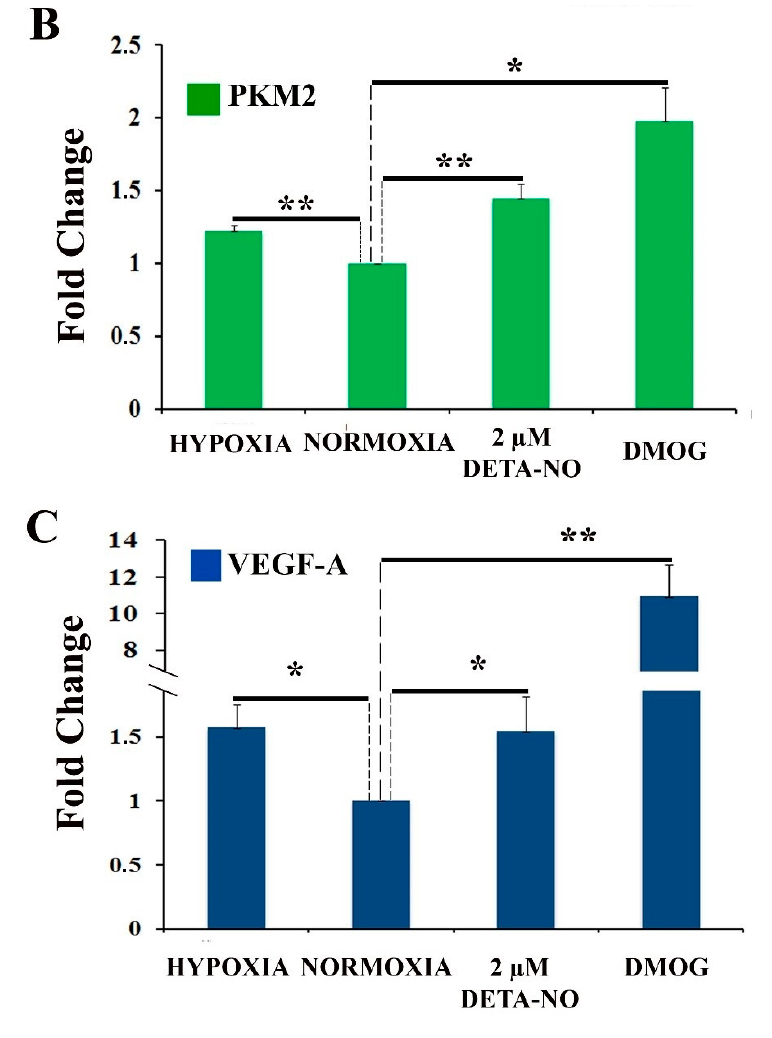
Figure 4. Exposure to 2 µ M DETA-NO induces an increase in mRNA level of HIF-1 α target genes in normoxia. MSUH-001 cells were cultured in normoxia for 6 days and subsequently exposed for 48 h to either 2 µ M DETA-NO under normoxia or hypoxia alone. When appropriate, cells were exposed for 4 h to the hypoxia inducer DMOG (1mM) under normoxia. ( A ) mRNA levels of glycolytic genes HK-2 (hexokinase 2), LDHA (lactate dehydrogenase A), and PDK1 (pyruvate dehydrogenase kinase 1) were measured by qPCR. Plotted data are the mean relative expression ± SEM of 4 independent experiments for HK-2 and LDHA and 5 experiments for PDK1. ( B ) Analysis of the relative expression of PKM2 (pyruvate kinase M1/2) by qPCR. The plot shows the mean of the relative expression ± SEM of 3 independent experiments. ( C ) Analysis of the relative expression at VEGF-A mRNA level by qPCR. The plot shows the mean of the relative expression ± SEM of 3 independent experiments. Expression values were normalized to the expression of the β -actin gene. Values were relativized to the normoxia control. (*) p < 0.05; (**) p <